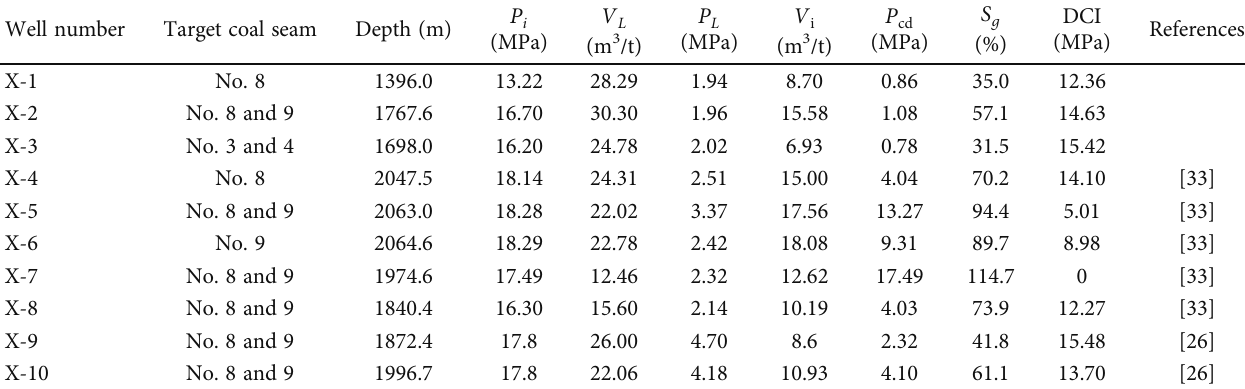
Table 3: Initial gas content and adsorption isothermal parameters of DCBM reservoirs.